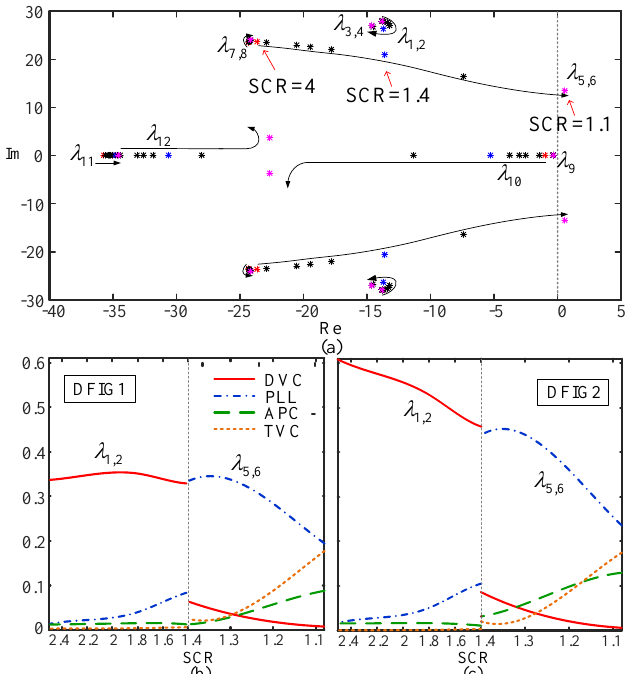
Figure 5. Stability analysis of the multi DFIGs system with varied grid strengths. ( a ) Eigenvalue locus. ( b ) Participation factor curves for dominant mode in DFIG1. ( c ) Participation factor curves for dominant mode in DFIG2.